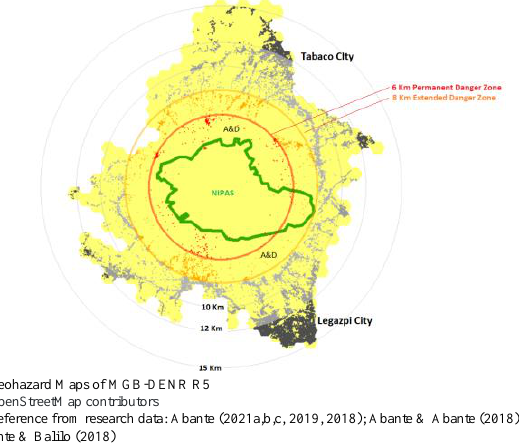
Figure 7 & 8 disclosed the following: (i) permanent danger zone relatively coincides with the landscape vulnerability hotspot and